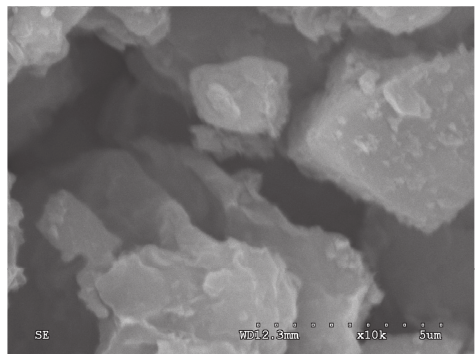
Figure 12: The soil of curing 0d and being magnified 10000 times.